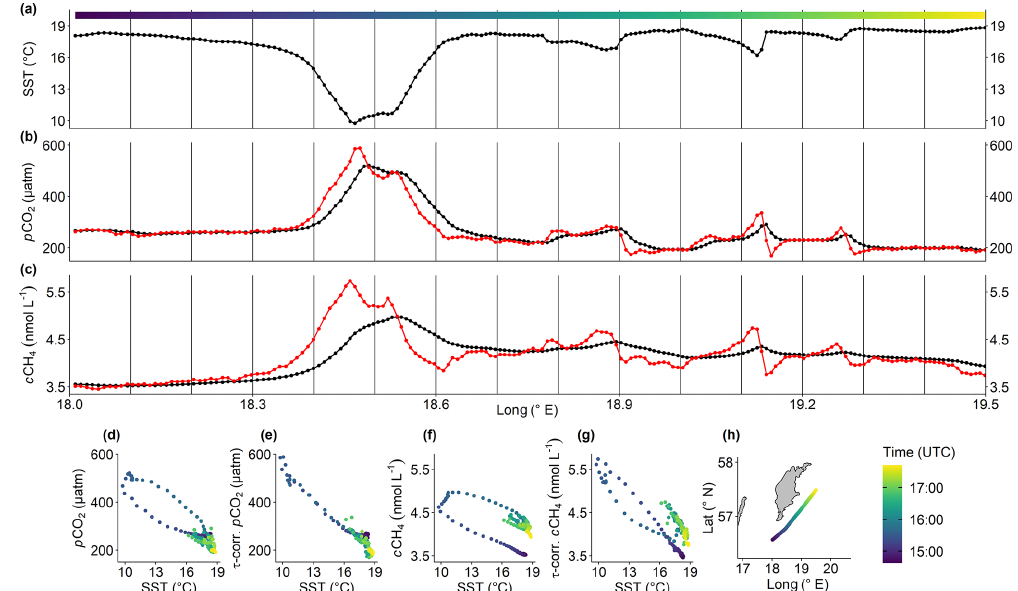
Figure A1. Demonstration of response time correction based on data from 24 August 2010 within the Go-SE box. The three upper plots display longitudinal patterns of (a) SST, (b) p CO 2 , and (c) c CH 4 . Black symbols are original values; red symbols are corrected using = 226s and τ = 676s (Gülzow et al., 2011) and procedures according to Bittig et al. (2018). Panels (d–g) reveal response times of τ CO CH 4 2 relationships between (d) original and (e) τ -corrected p CO 2 and SST as well as (f) original and (g) τ -corrected c CH 4 and SST. Panel (h) displays the position of SOOP Finnmaid over time. Time is colour-coded to link all plots.